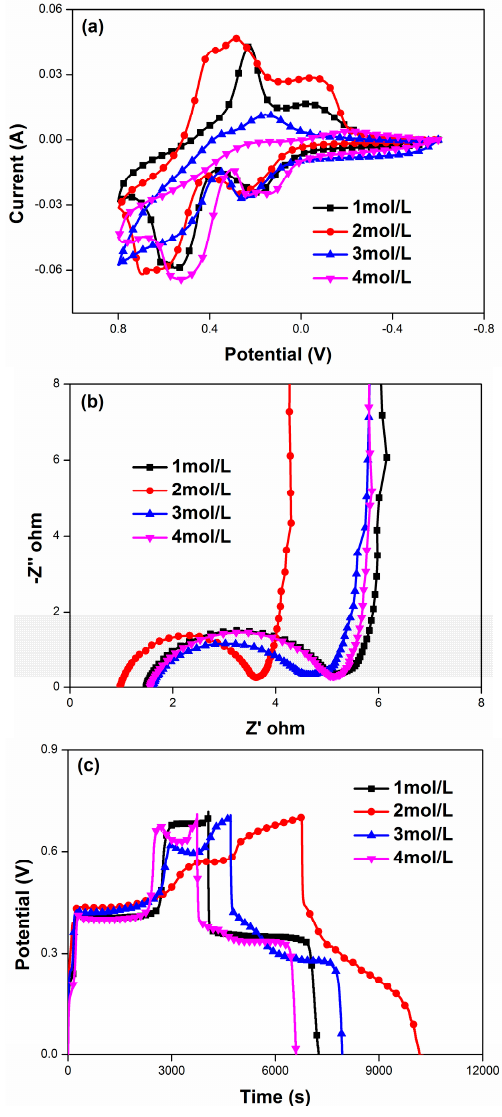
Figure 6. The CV ( a ); EIS ( b ); and GCD ( c ) results of PANI/A-MWCNTs in 1 M H 2 SO 4 with different concentrations of HQ. Table 2. The specific capacitance, electrolyte resistance, and charge-transfer resistance at different HQ concentration.